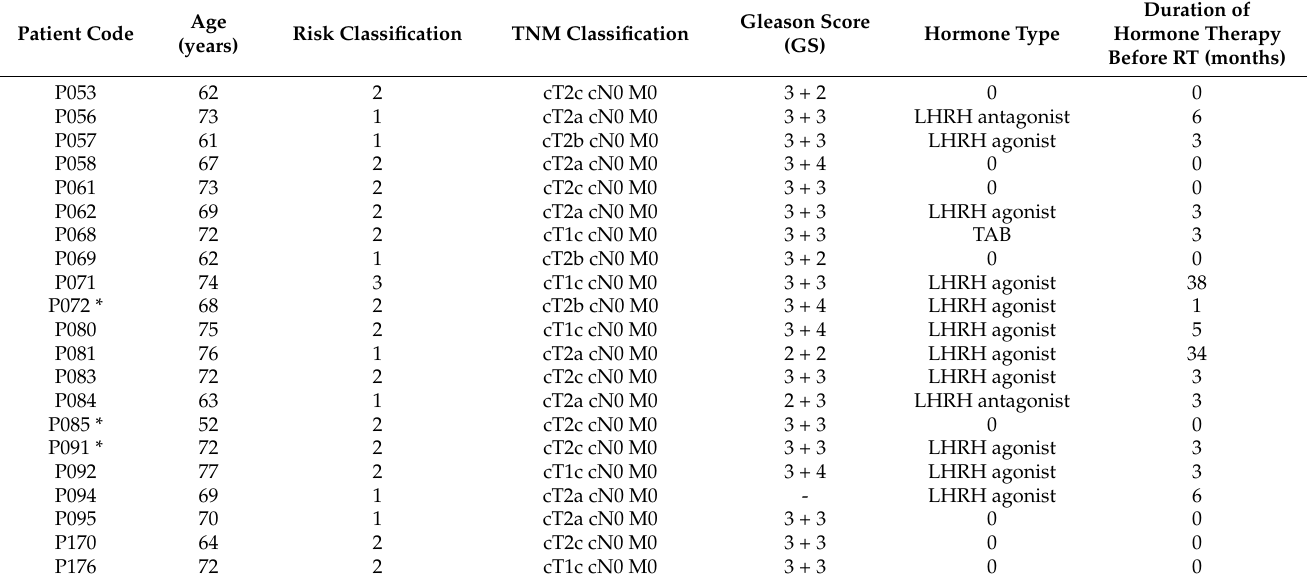
Table 1. Demographics and clinical parameters of prostate cancer patients receiving low-dose rate brachytherapy. Risk classification scale is from 1 to 3. Low risk (1): PSA level before therapy < 10 ng/mL, GS 2-6 and T1-T2a; medium risk (2): PSA level before therapy = 10–20 ng/mL and/or GS 7 and/or T2b. Patient 94 had no Gleason score because of the unsuccessful biopsy. * patient